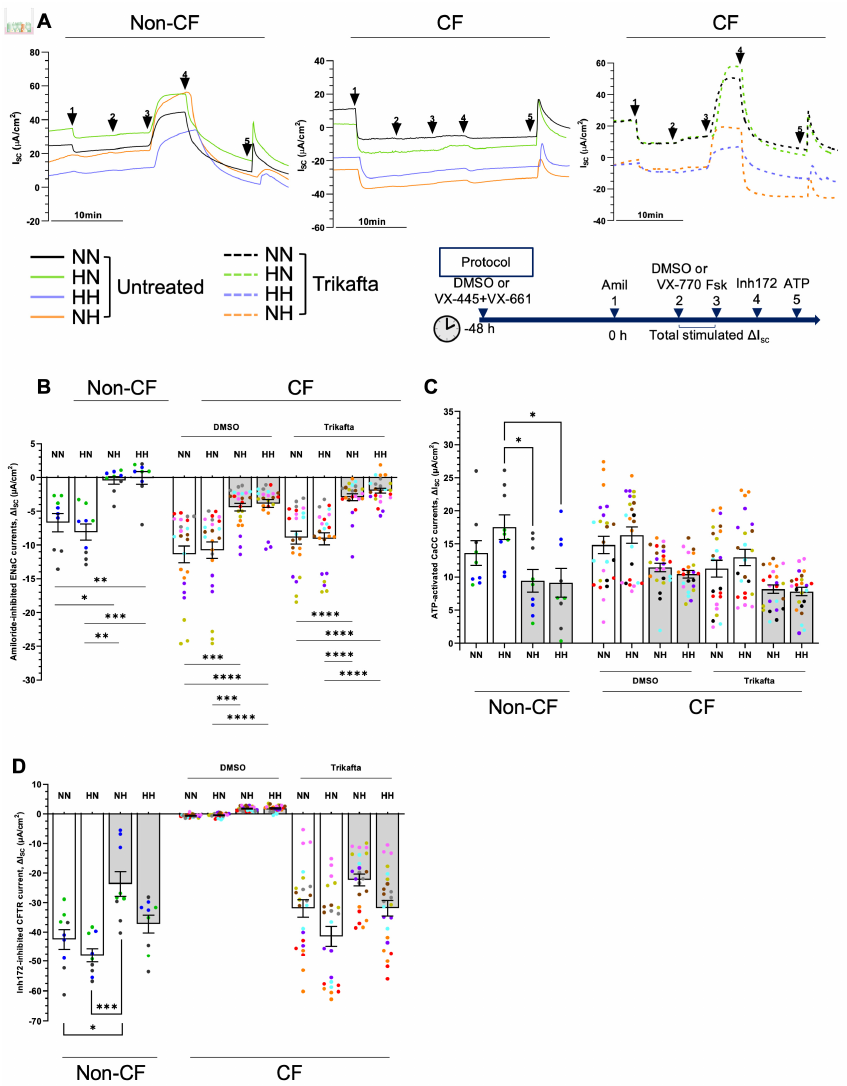
Figure 6. Effect of chronic hypoxia on ion transport function in differentiated human nasal epithelial cells (hNECs). ( A ) Representative Ussing chamber recordings of short circuit current (Isc) in hNECs from a non-CF and a CF participant. The protocol used to measure functional CFTR expression in hNECs in 0.01% DMSO vehicle (untreated) or pretreated with correctors (3 µM VX–445 and 18 µM VX–661 for 48 h) followed by sequential addition of 100 µM apical amiloride (1. Amil), apical addition of either vehicle control 0.01% DMSO or 10 µM VX–770 (2. DMSO or VX–770), 10 µM basal forskolin (3. Fsk), 30 µM apical CFTR inhibitor (4. CFTRinh–172), and 100 µM apical ATP (5. ATP). A basolateral-to-apical chloride gradient was used. Black line denotes NN, green line denotes HN, orange line denotes NH, and purple line denotes HH. Box plots of ( B ) amiloride-inhibited epithelial sodium channel (ENaC) currents, ( C ) ATP–activated calcium-activated chloride channel (CaCC) currents, ( D ) Inh172–inhibited CFTR current (bo tt om) in hNECs untreated or pretreated with VX–445 and VX–661. Each individual participant’s data is presented with a di ff erent color. Three independent transwells were analyzed per participant. Data are presented as bar plots with mean ± standard error of the mean (SEM). One-way ANOVA was used to determine statistical signi fi cance. * p < 0.05, ** p < 0.01, *** p < 0.001, and **** p < 0.0001.